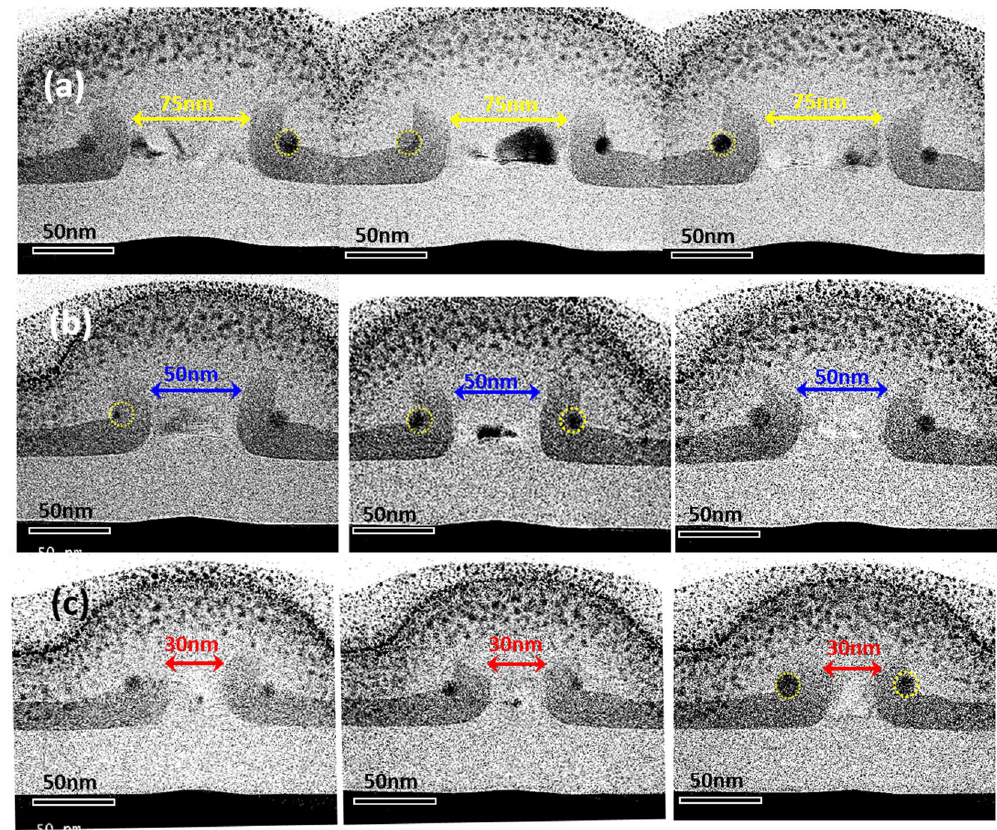
Figure 7. Extensive TEM observations of Ge QDs simultaneously fabricated at each sidewall corner of nano- patterned Si 3 N 4 /Si ridges with widths ranging from ( a ) 75 nm, ( b ) 50 nm and ( c ) 30 nm showing a high degree of symmetry, uniformity and reproducibility for the